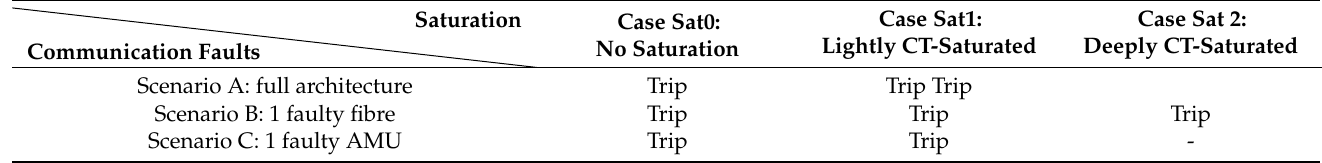
Table 7. Trip signals obtained for CT saturation tests for all types of faults